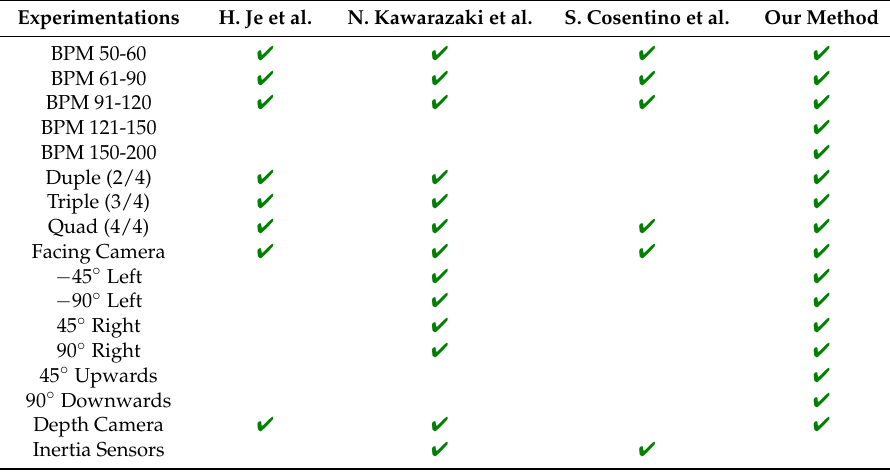
Table 8. Comparisons of related work with our